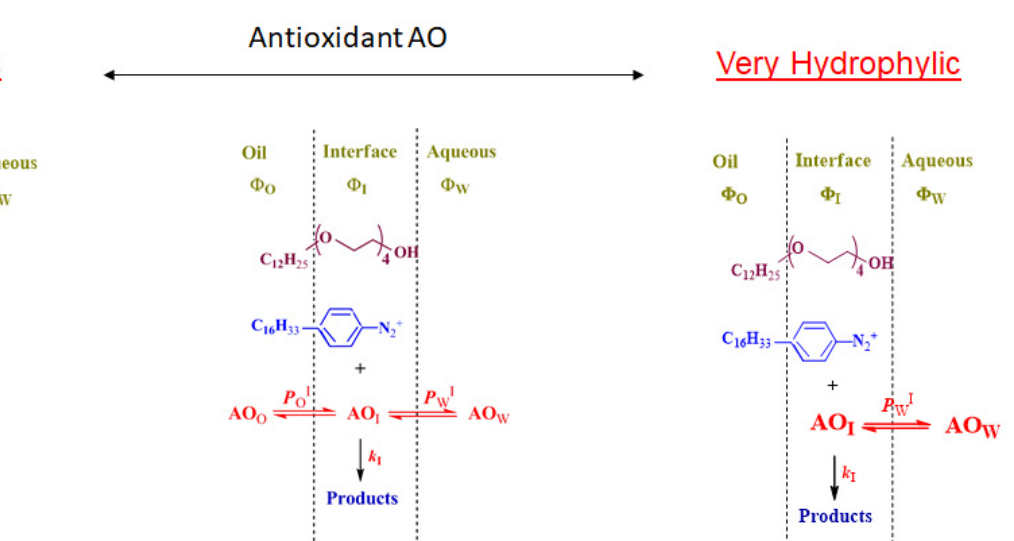
Figure 11. Partitioning of antioxidants in emulsions according to their polarity. In general, two partition constants are needed to define their distributions, but two limiting situations where only one partition constant is needed can be found. The first limiting situation when considering very hydrophilic antioxidants (e.g., phenolic acids) is that they are essentially oil-insoluble and only P WI is needed to define their distribution. The second limiting situation is found when considering water-insoluble antioxidants (i.e., very hydrophobic antioxidants such as tocopherol). In these cases, the antioxidants only partition between the interfacial (I) and oil (O) regions and their distributions are described by the partition constant P OI [88–92]. Figure reproduced from S. Losada-Barreiro, PhD Thesis, Universidad de Vigo, 2014, with